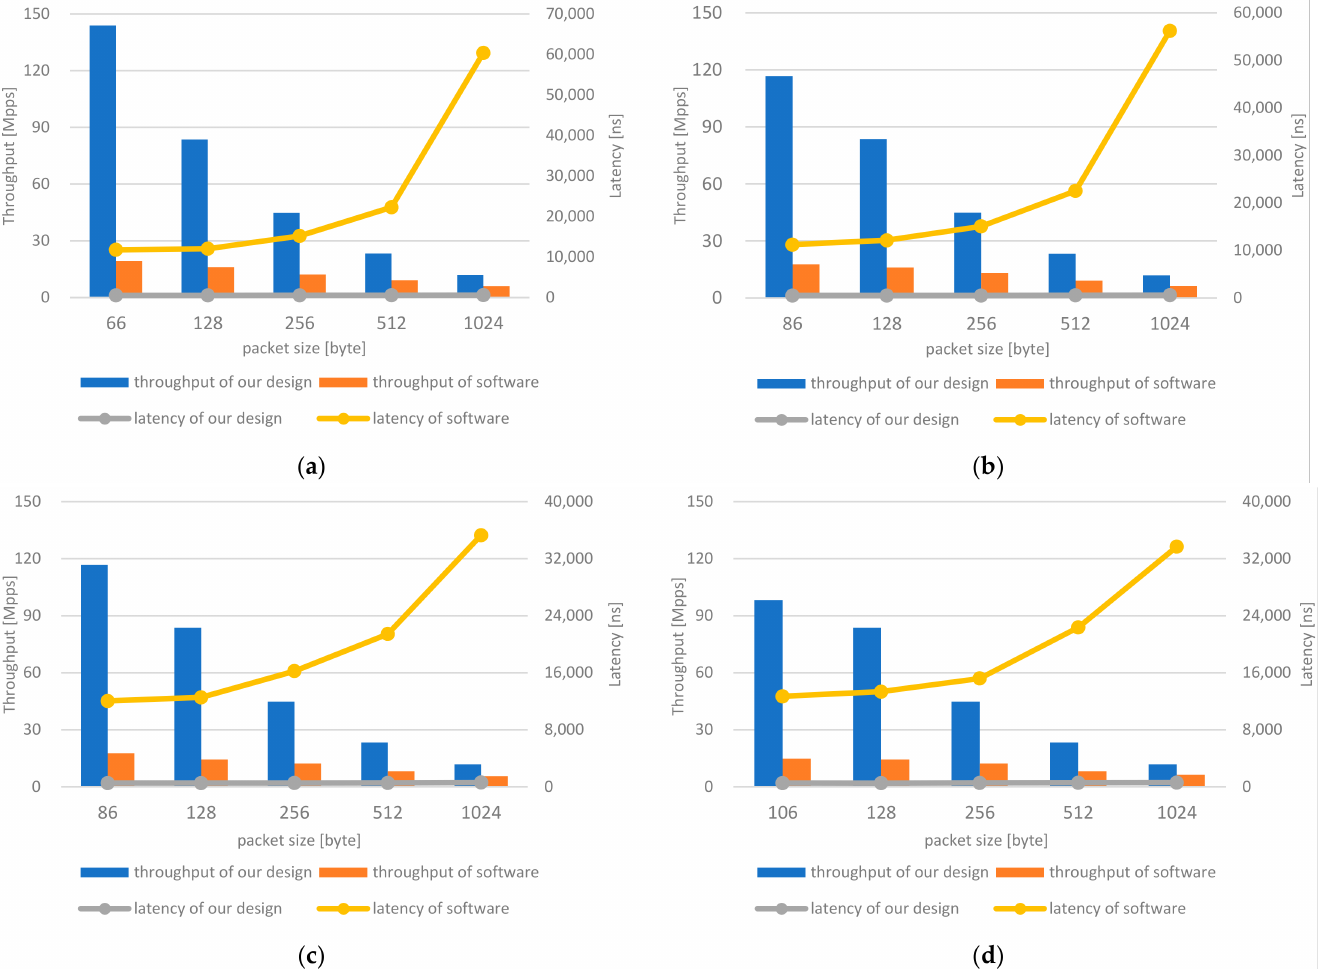
Figure 23. Performance comparison of different functions between our architecture and OVS-DPDK. ( a ) Result of LPM rule table with pure IPv4 traffic; ( b ) result of LPM rule table with pure IPv6 traffic; ( c ) result of EM rule table with pure IPv4 traffic; ( d ) result of EM rule table with pure IPv6